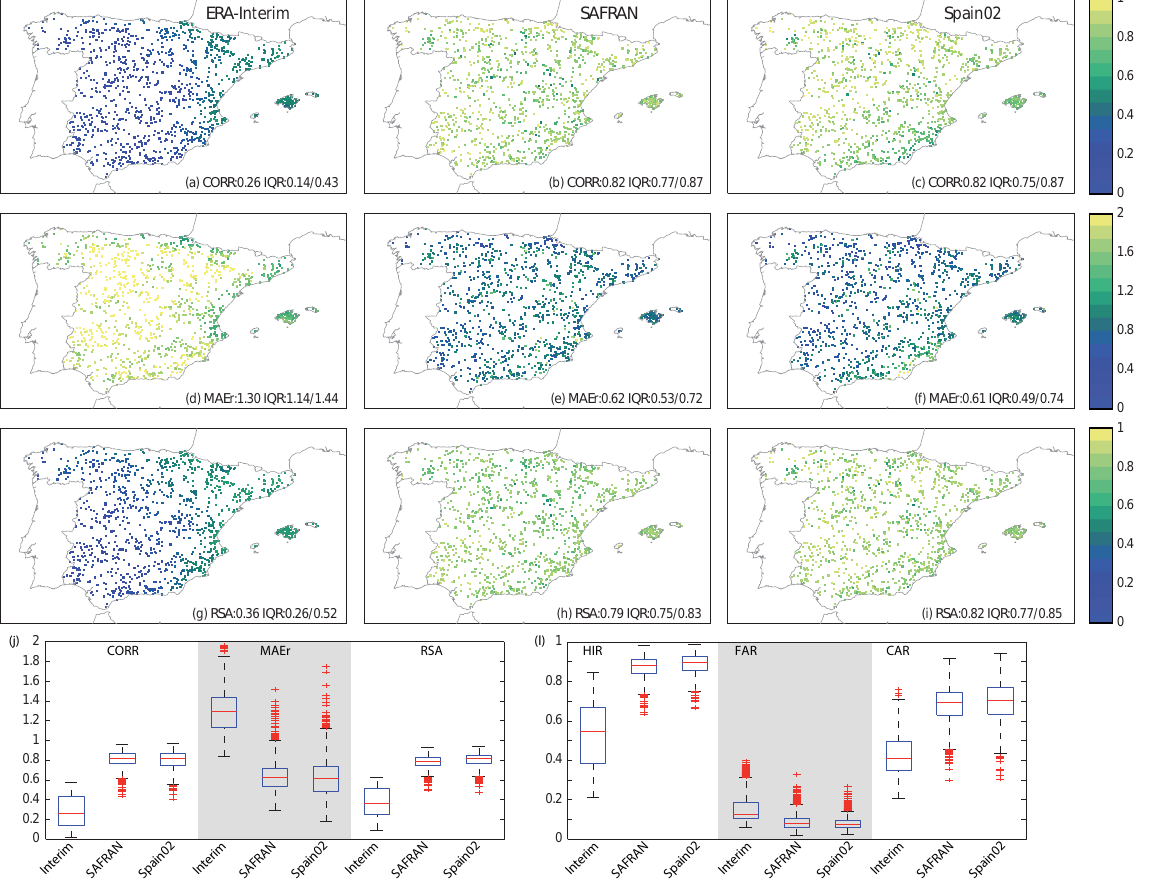
Figure 3. The correlation (a–c) , relative mean absolute error (d–f) and ROC skill area (g–i) of ERA-Interim, SAFRAN and Spain02 with regard to the observations. The lower row shows the box plots of the (j) CORR, MAEr, and RSA as well as the (l) HIR, FAR, and CAR for the three datasets, reflecting the spatial variability of the